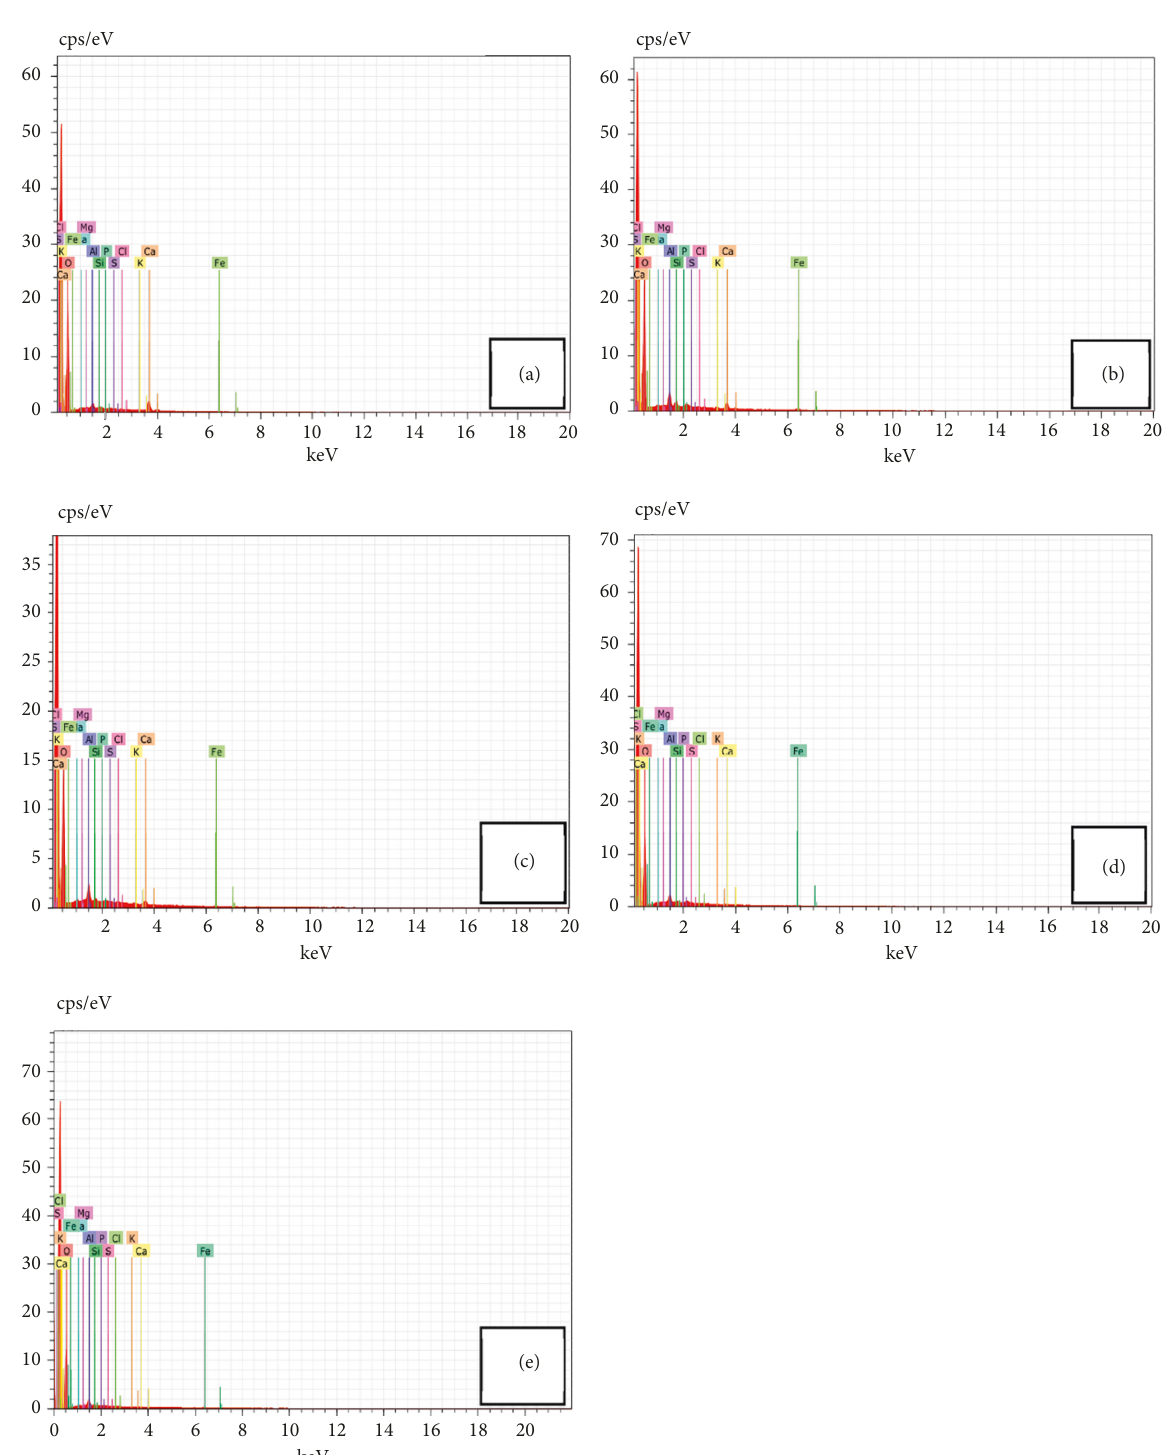
Figure 3: KPLF SEM (EDS) test results: (a) TP, (b) P1J, (c) P2J, (d) P3J, and (e)